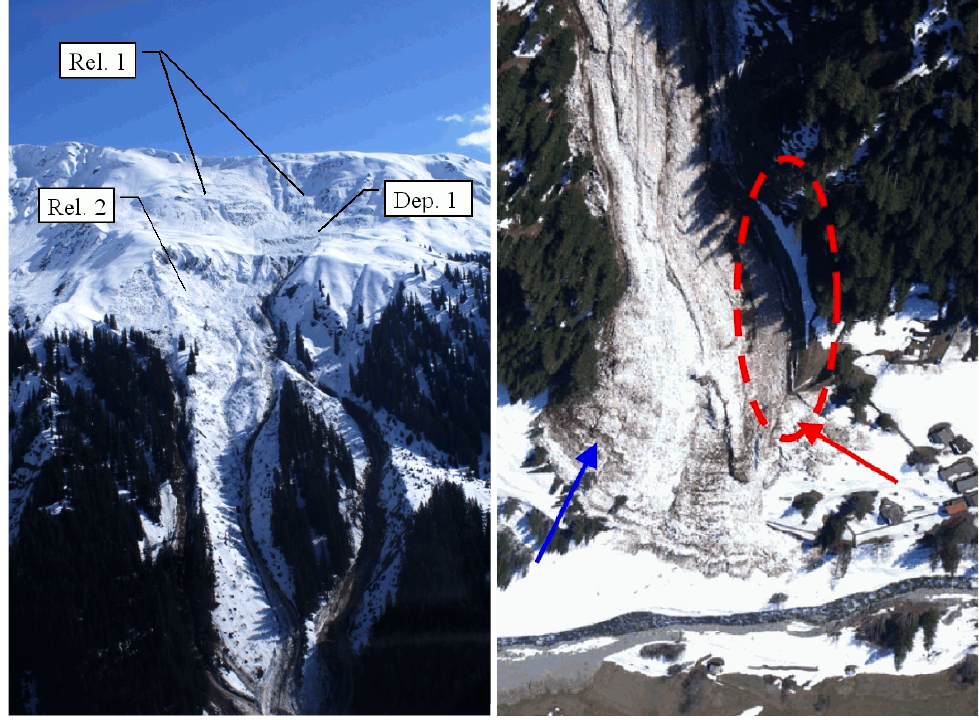
Fig. 1. Gatschiefer avalanche of April 2008. On the left, release zones ] 1 and ] 2, deposit ] 1, and the upper flowing zone. On the right, main deposit ] 2. The red circle indicates the dam location, the blue arrow the area where several trees were uprooted, and the red arrow the dam